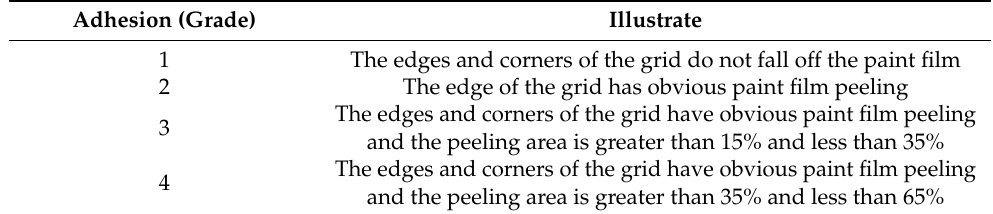
Table 4. Paint film adhesion grade classification sheet. Adhesion (Grade) Illustrate 1 The edges and corners of the grid do not fall off the paint film 2 The edge of the grid has obvious paint film peeling The edges and corners of the grid have obvious paint film peeling 3 and the peeling area is greater than 15% and less than 35% The edges and corners of the grid have obvious paint film peeling 4 and the peeling area is greater than 35% and less than 65%